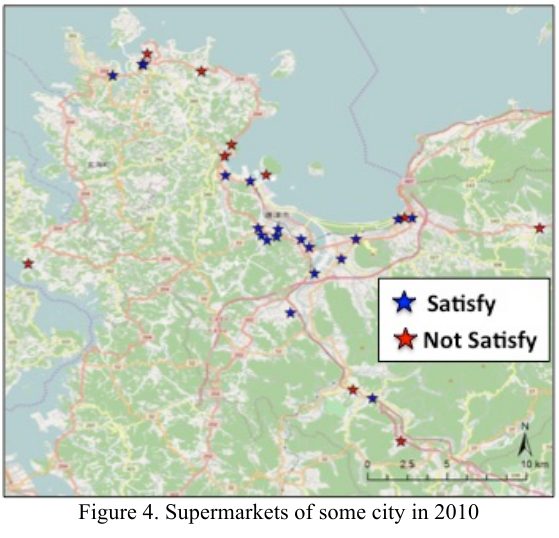
Figure 4. Supermarkets of some city in 2010